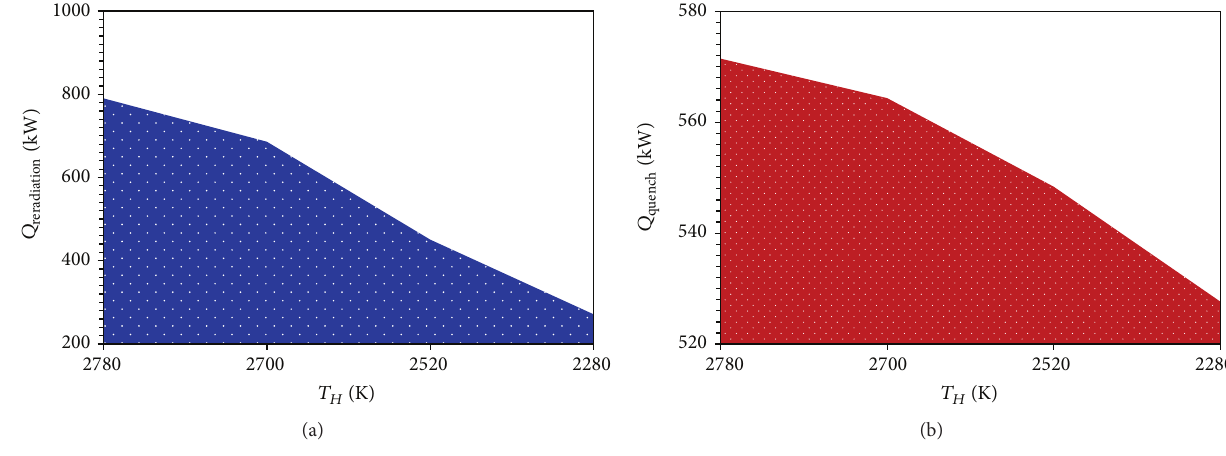
Figure 8: Effect of 𝑇 𝐻 on (a) 𝑄